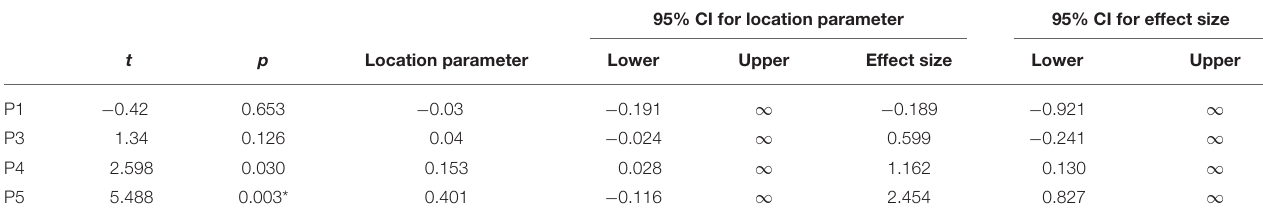
TABLE 2 | Frequentist one sample t tests (H1 A ) on subject level.